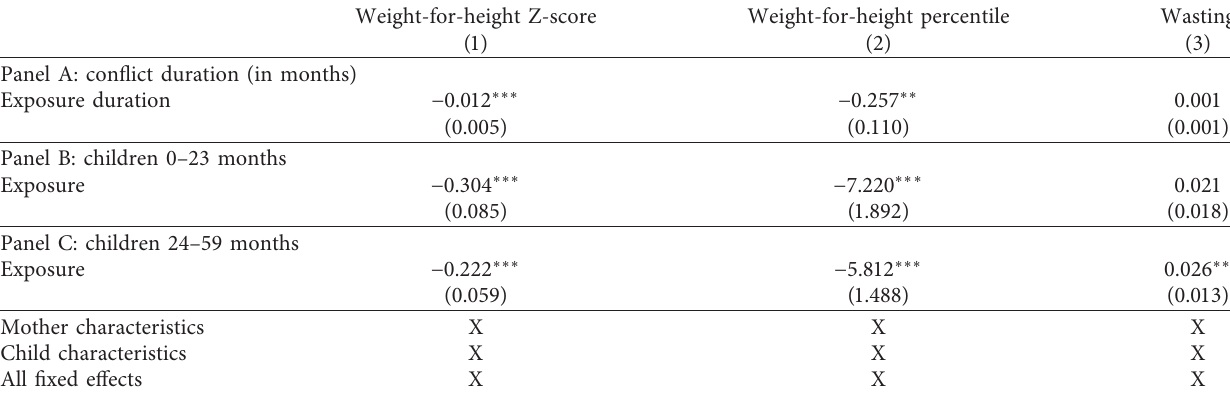
Table 6: Exposure to armed conflict on child weight-for-height: other tests.